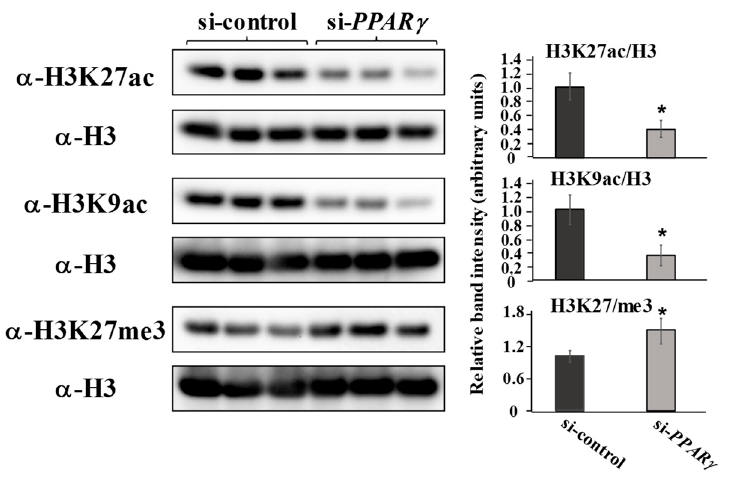
Figure 4. PPAR γ suppression inhibits the global acetylation of H3K9 and H2K27 . PDLF-1 were transfected with si-control or si- PPAR γ for 24 h and then recovered in normal growth medium for another 24 h. Total histones were collected and histone modifications, such as H3K27ac, H3K9ac, and H3K27me3, were examined using specific antibodies. Band intensities are normalized against those obtained using the antibody for whole histone 3. * p < 0.05 significantly lower than in cells transfected with si-control.